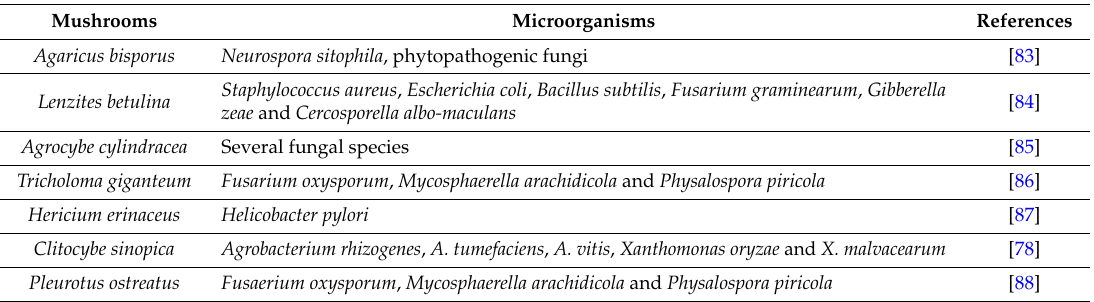
Table 3. Antimicrobial activities of some